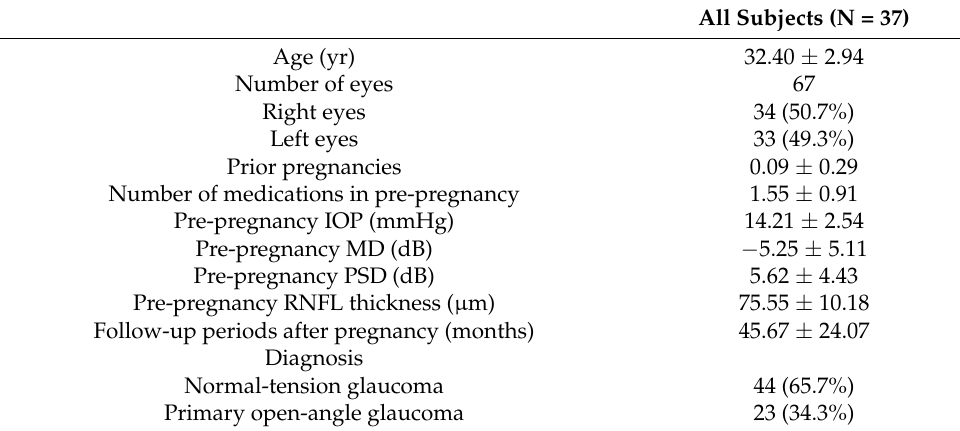
Table 1. Clinical characteristics of the study